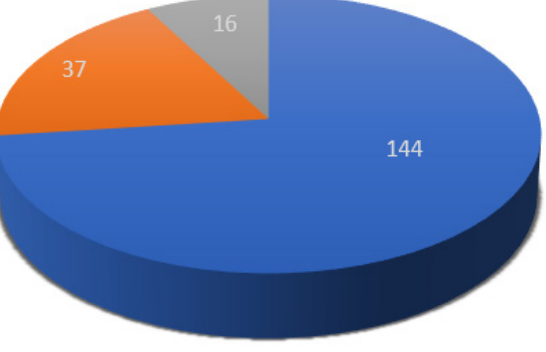
Figure 4. Number of rice varieties were assigned for plant breeder’s rights in 2017.